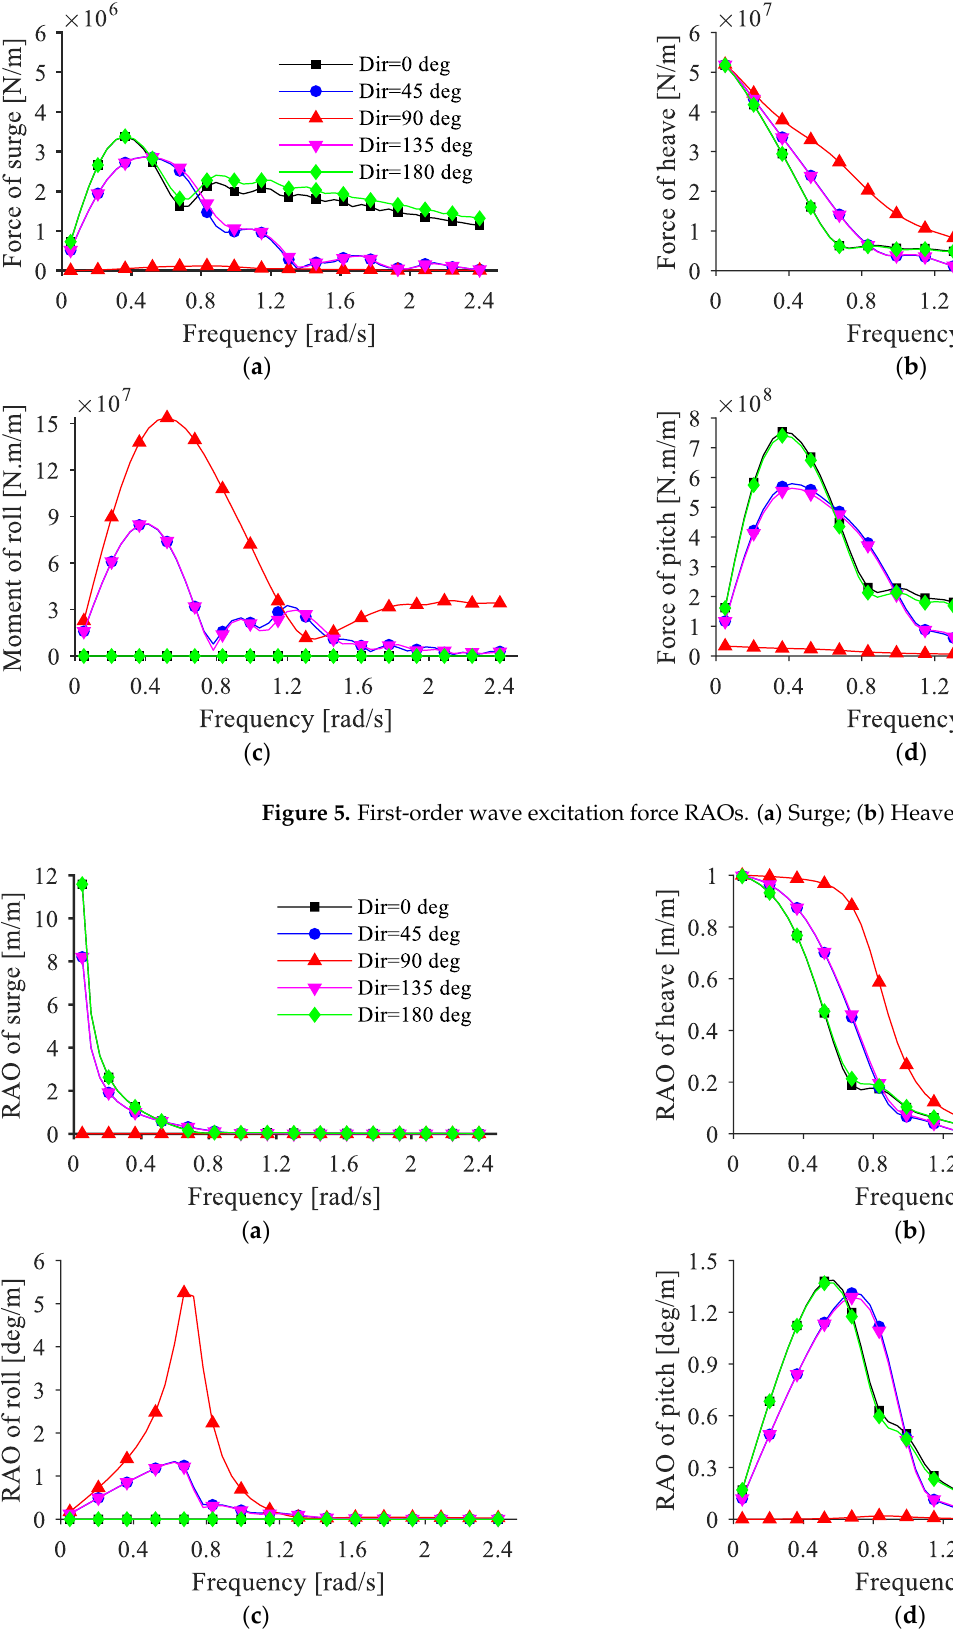
Figure 6. Motion RAOs. ( a ) Surge; ( b ) Heave; ( c ) Roll; ( d ) Pitch.